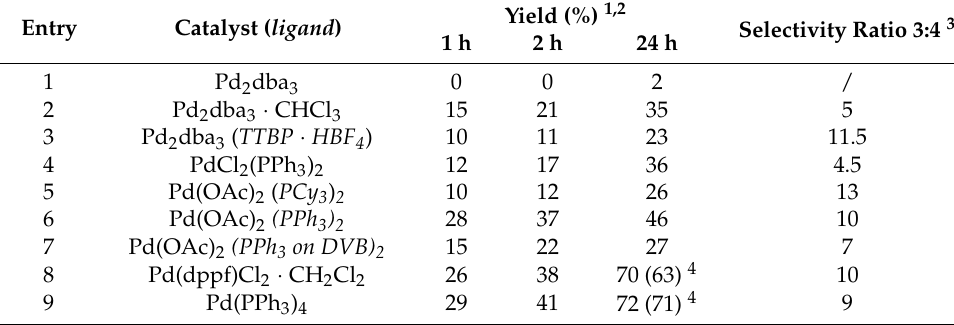
1 Reaction conditions: 1 (75 mg, 0.50 mmol), 1,4-dioxane (3.5 mL), K 2 CO 3 (207 mg, 1.50 mmol), 2 (61 mg, 0.50 mmol), 5 mol% of a catalyst (10 mol% of a ligand ), 100 ◦ C, 1–24 h. 2 Determined by LC-MS. 3 Determined by LC-MS after 24 h reaction time. 4 Isolated yield of 3 after extraction and column